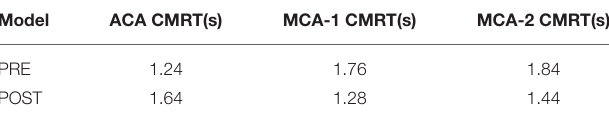
TABLE 4 | The CMRT for the patient-derived